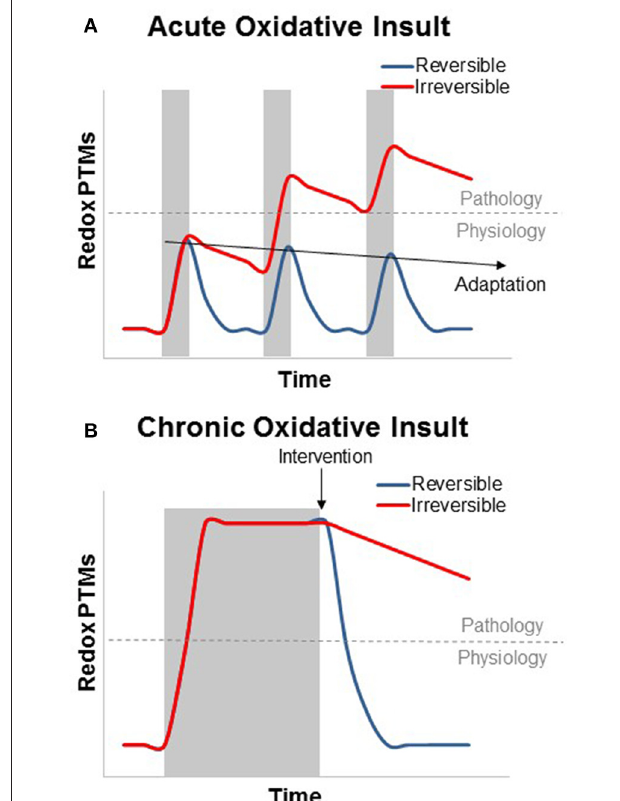
FIGURE 1 | Theoretical graph of the transient and additive nature of reversible and irreversible redox PTMs in the context of skeletal muscle physiology and disease. (A) Acute oxidative insults (shaded area) can cause a swift and transient increase in reversible oxidative PTMs. Irreversible PTMs rely on protein degradation and turnover, while most reversible modifications can be cleared by the GSH/GSSG and Trx(red)/Trx(ox) redox couples. Subsequent acute oxidative insults can be deleterious if the modifications become irreversible, but this is not the case for reversible modifications, which, can cause transcriptional activation of the antioxidant response (adaptation, preconditioning, or hormesis) to suppress PTM formation. (B) Chronic oxidative insults can result in an oxidized redox status which persists throughout the duration of the stress. As with aging, many metabolic and functional skeletal muscle defects that result from this oxidized redox status can be rapidly reversed by restoring a more reduced redox environment. In contrast, irreversible oxidative modifications, however, can persist after the end of the oxidative